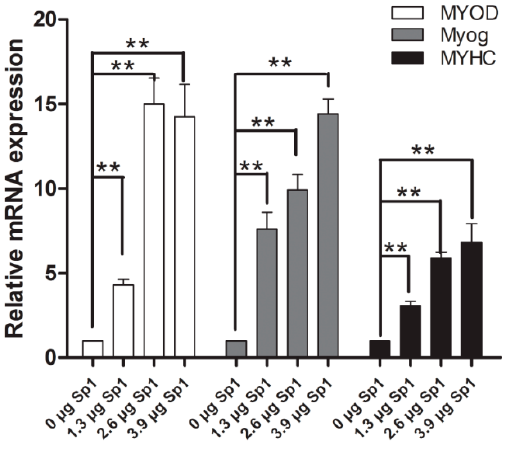
Figure 5. Sp1 promotes the process of myogenesis. Over-expression of Sp1 significantly stimulated MyoD , MyoG , MyHC mRNA expression in C2C12 cells, ** p < 0.01.